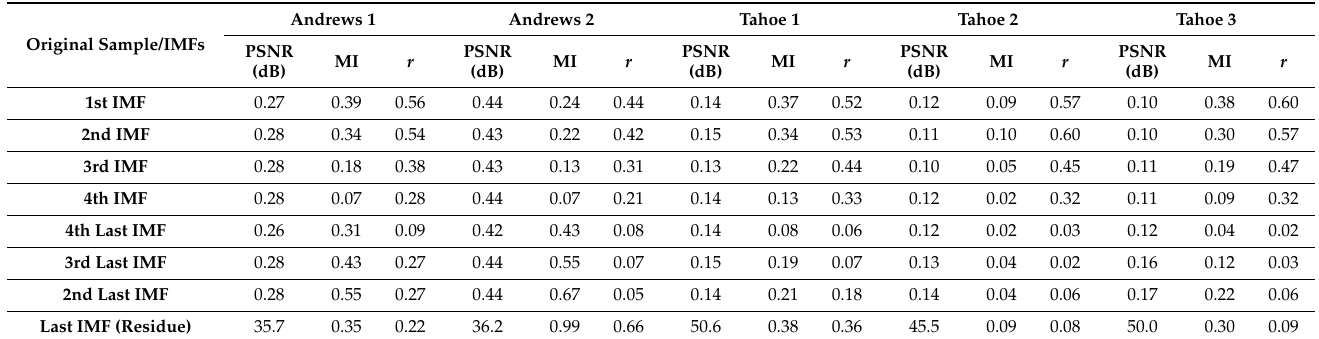
Table 1. Quantitative Results for Empirical Analysis of MEMD Derived Intrinsic Mode Functions (IMFs)—1st Four and Last Four Based on PSNR (Peak Signal To Noise Ratio), Mutual Information And Pearson’s Correlation Coefficient ( r ) for the Selected Samples. Andrews 1 Andrews 2 Tahoe 1 Tahoe 2